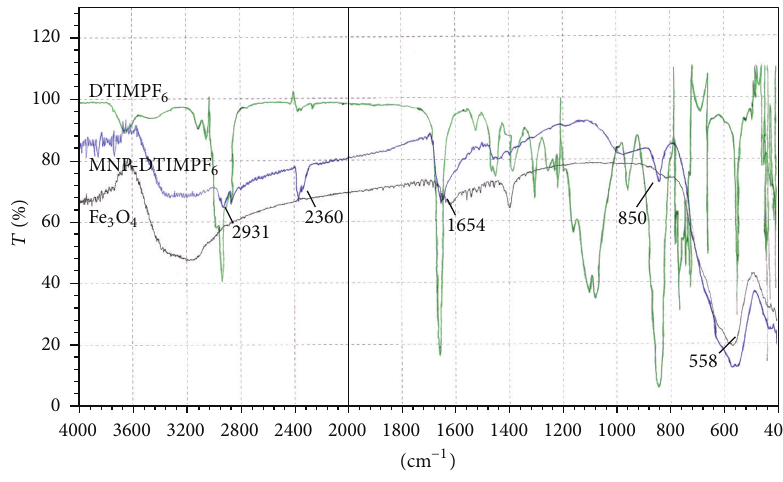
Figure 1: IR spectra of Fe 3 O 4 , DTIMPF 6 , and MNP-DTIMPF 6 .